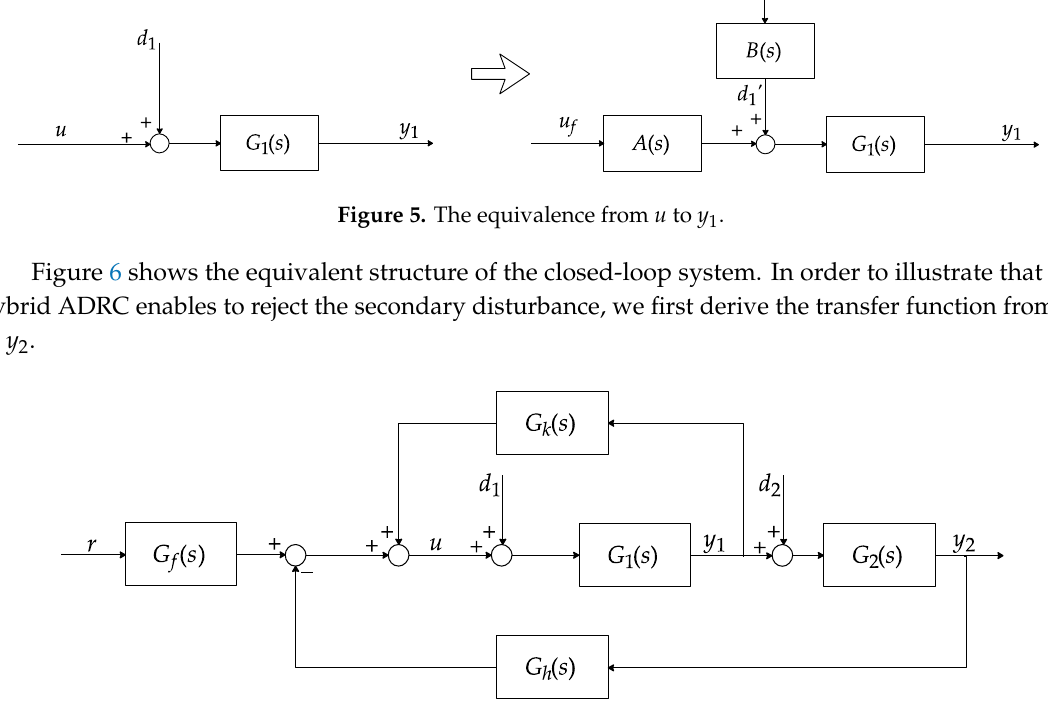
Figure 6. The equivalent block diagram of the closed-loop system.